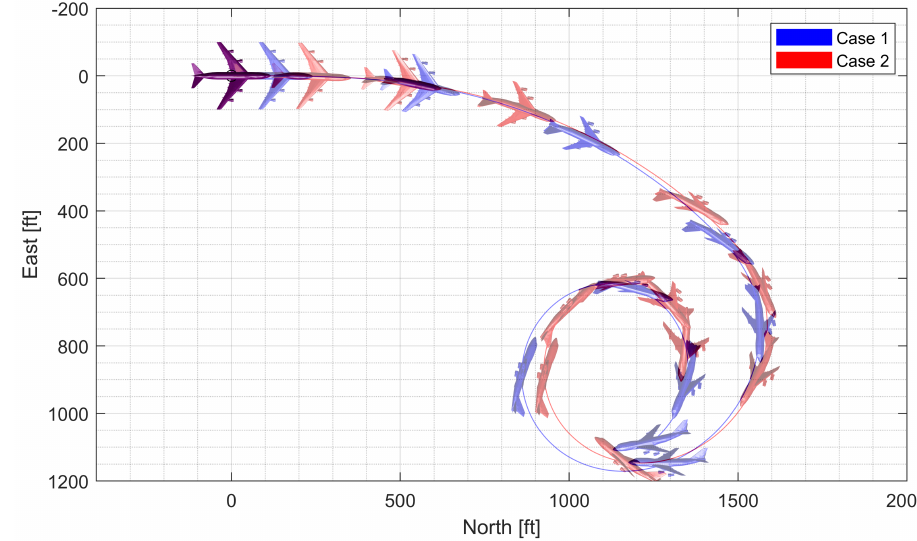
Figure 16. Flight trajectory of the high-g turn ( H ∞ ).